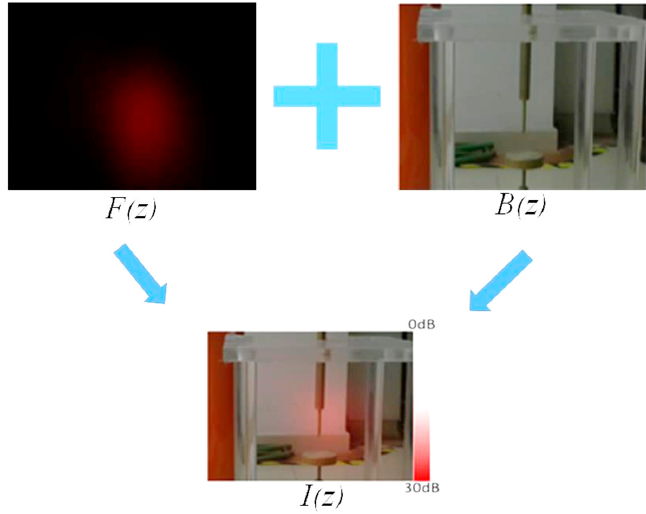
Figure 4. Results of image fusion.